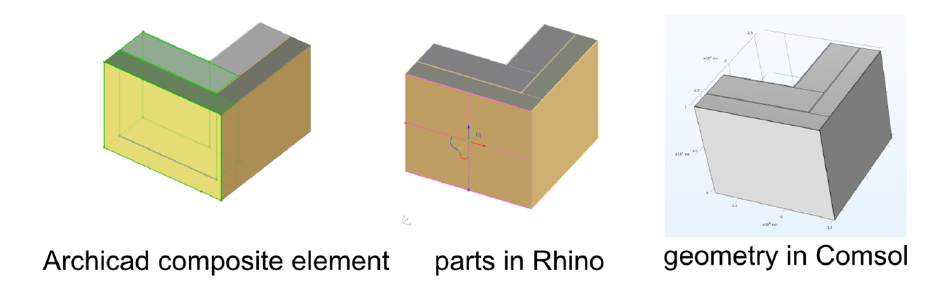
Figure 7. Stages of model conversion from Archicad to